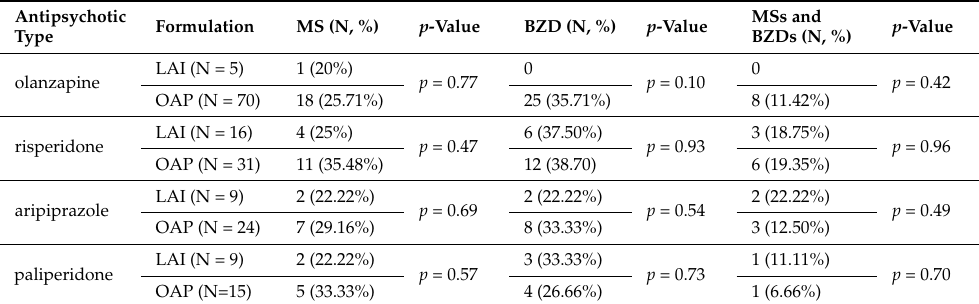
Table 4. Concomitant treatment by antipsychotic